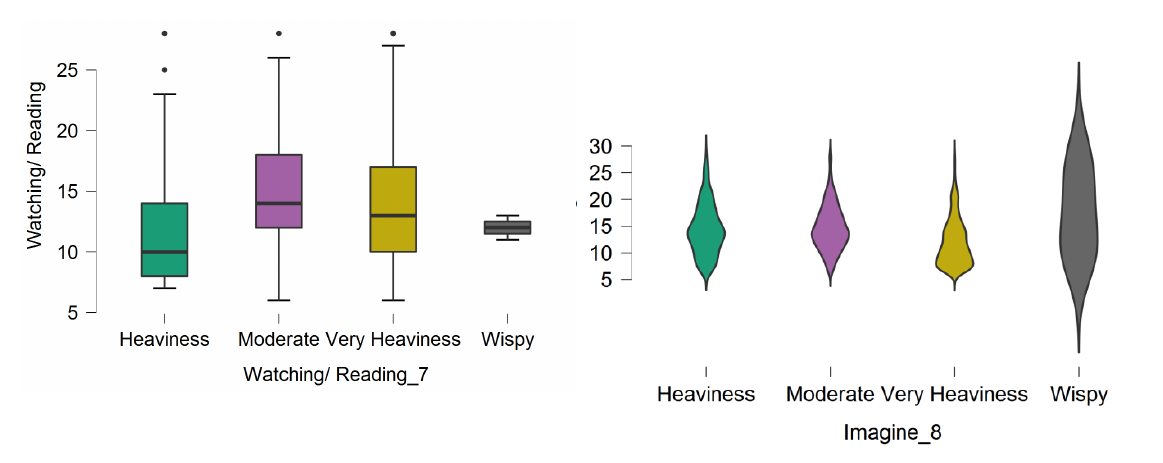
Figure 7. Watching/Reading Aspect Figure 8. Watching/Reading